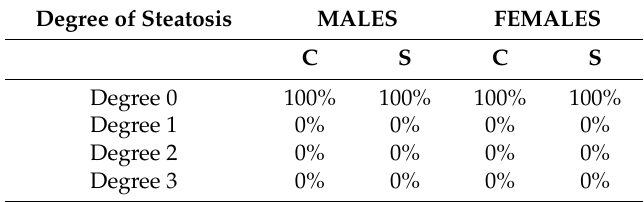
Table 1. Degree of liver steatosis of adult offspring programmed by smoke exposure. Degree of Steatosis